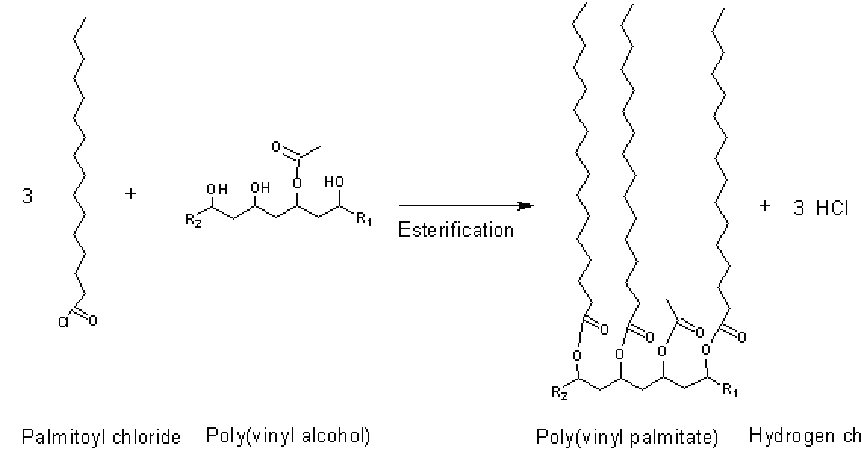
Figure 1. The reaction of poly(vinyl alcohol) (PVOH) with fatty acid chlorides (example: reaction of palmitoyl chloride (C16) with the hydroxyl groups of PVOH, producing poly(vinyl palmitate) and hydrogen chloride); R1 and R2 represent the continuation of the PVOH chain. This is just a scheme showing the principals of the reaction. Please note that the reaction took place on deposited PVOH films and not on free